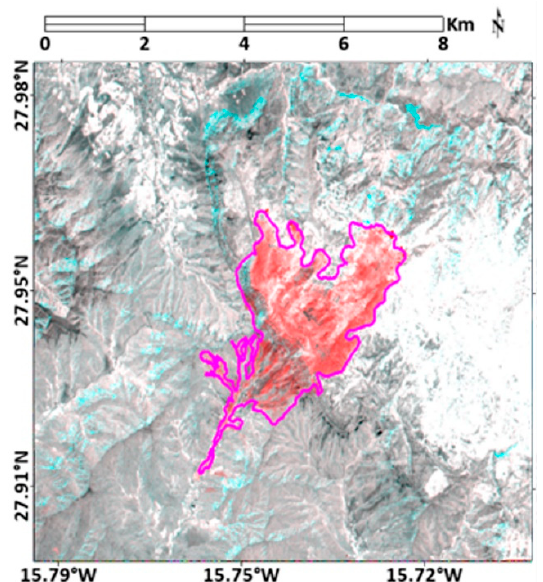
Figure 9. RGB color composite of the S2 images of the Tasarte fire (EMSR428). Red: NBR2 pre-fire ; green and blue: NBR2 post-fire . The magenta line represents the boundary of the CEMS-derived burned area.